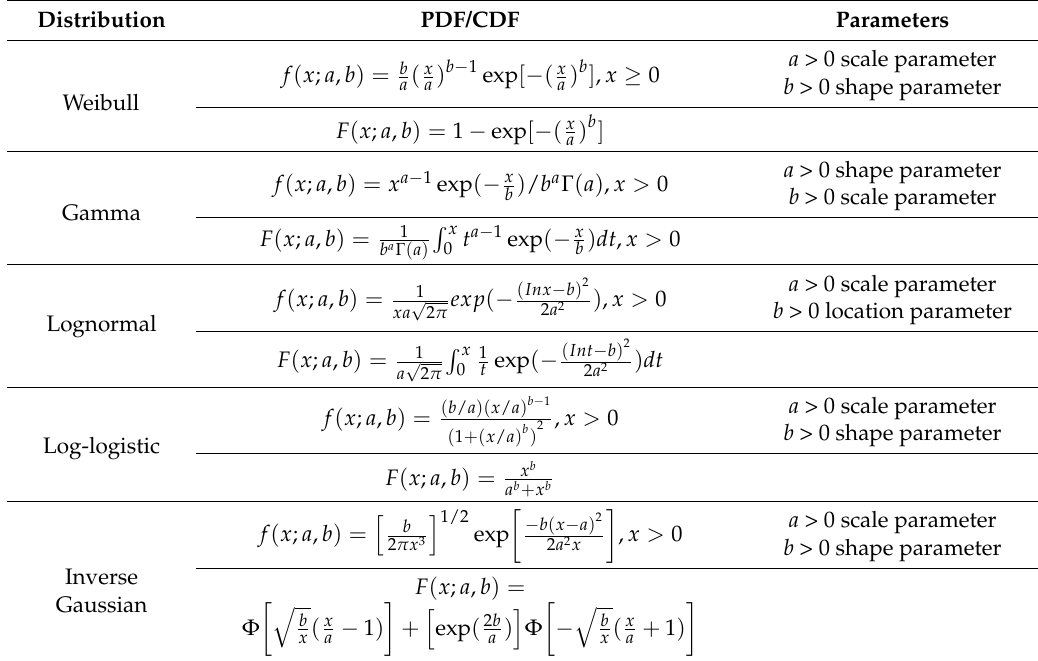
Table A1. The PDF and CDF of five kinds of distributions.